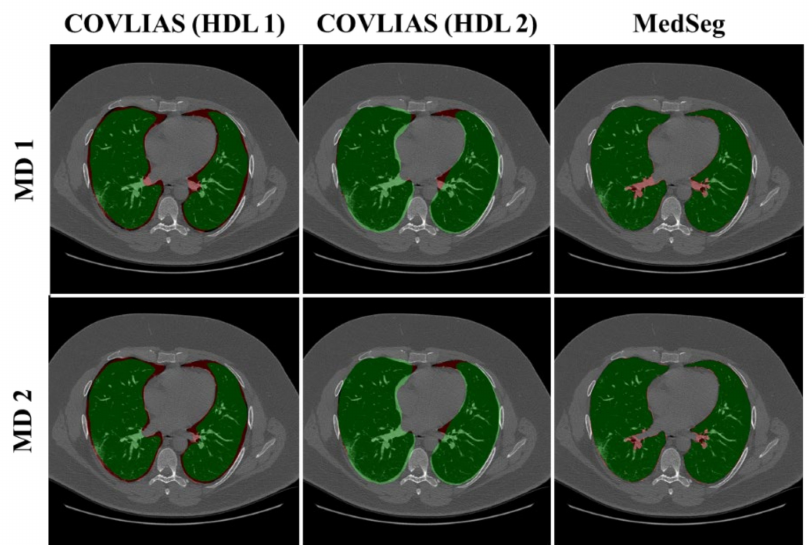
Figure 10. COVLIAS (HDL 1) (green) in column 1; COVLIAS (HDL 2) (green) in column 2; MedSeg (green) in column 3, MD 1 in row 1 (red); MD 2 in row 2 (red).